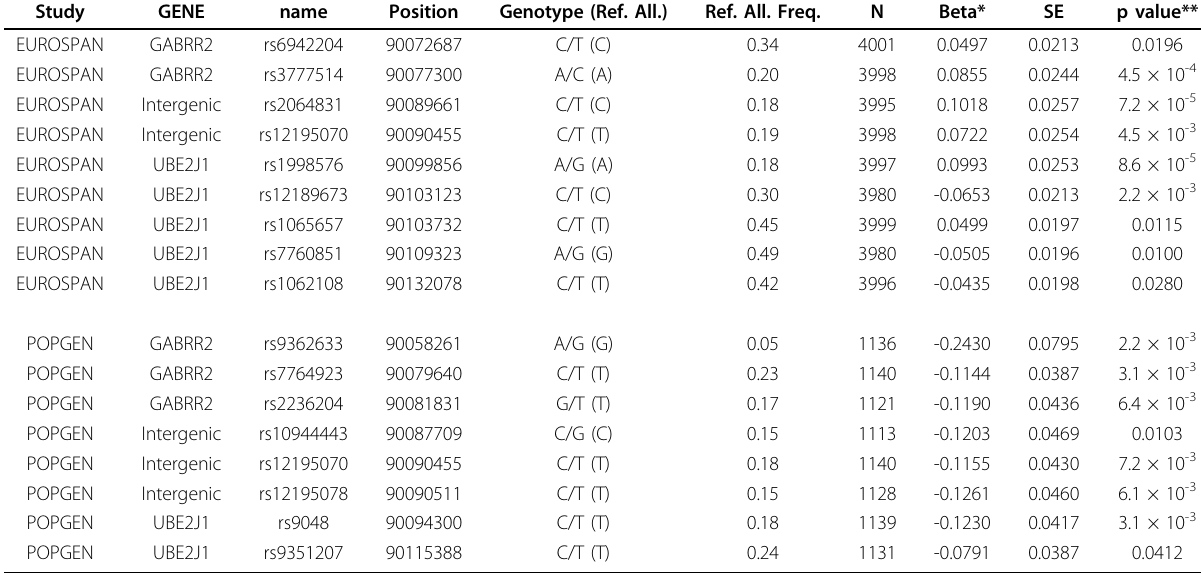
Table 4 SNPs with the highest evidence of association in the region including the GABRR2 and the UBE2J1 genes (chromosome 6) #